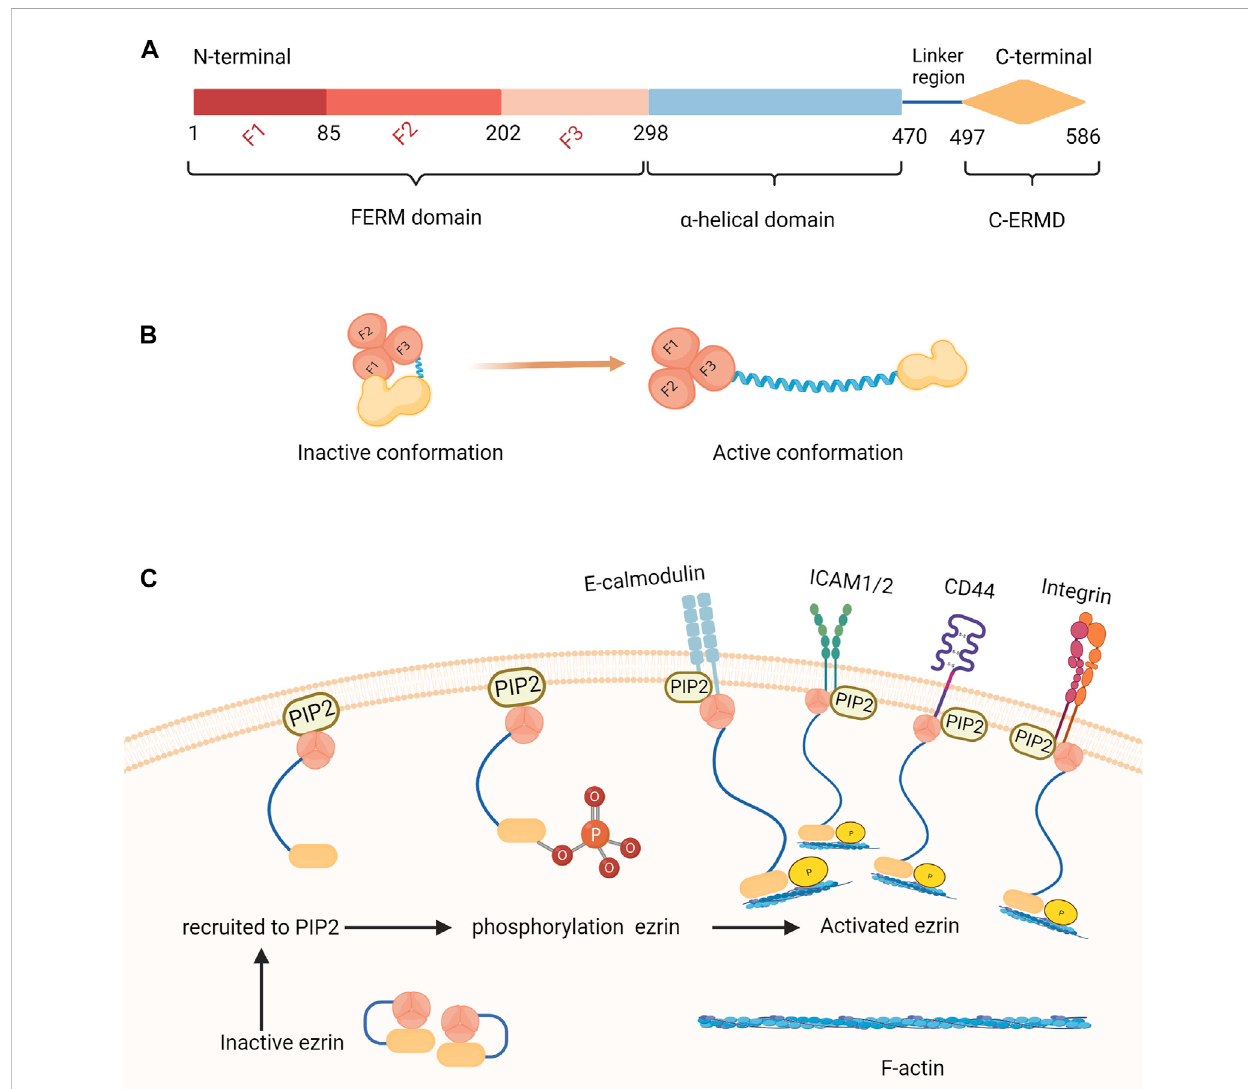
Structure and activation process of ezrin. (A) Ezrin is composed of 586 amino acids and contains three main structural domains: The domain structure includes the FERM domain (N-terminal) which is a highly conserved globular structure of 296 amino acids and can be directly or indirectly attachedtothecellmembrane,the α -helixstructuraldomainandtheC-ERMADdomain(C-terminus)whichcanconnecttoF-actinandtheFERMregion. (B) The inactive state and active conformation of ezrin:Ezrin is inactive in the resting state, but it connects to the cell membrane and cytoskeleton when phosphorylated and reverts to a closed state after dephosphorylation. (C) The process of the activation of ezrin: Ezrin can become activated by phosphorylation of the C-terminal threonine residue (Thr567), phosphorylation of tyrosine (Tyr353) or N-terminal binding to phosphatidylinositol biphosphate (PIP2). Activated ezrin protein mediates signaling pathways though bonding to the molecules on the cell membrane surface to maintain apical-basal cell polarity and normal cell morphology, and remains the consistency of cell-cell contacts through binding to actin fi laments. Ezrin protein also participates in cell adhesion and can form complexes on the cell surface with various cell adhesion molecules such as CD44, E-calmodulin, and integrin, which are involved in cell adhesion, deformation, and migration by regulating actin shape.